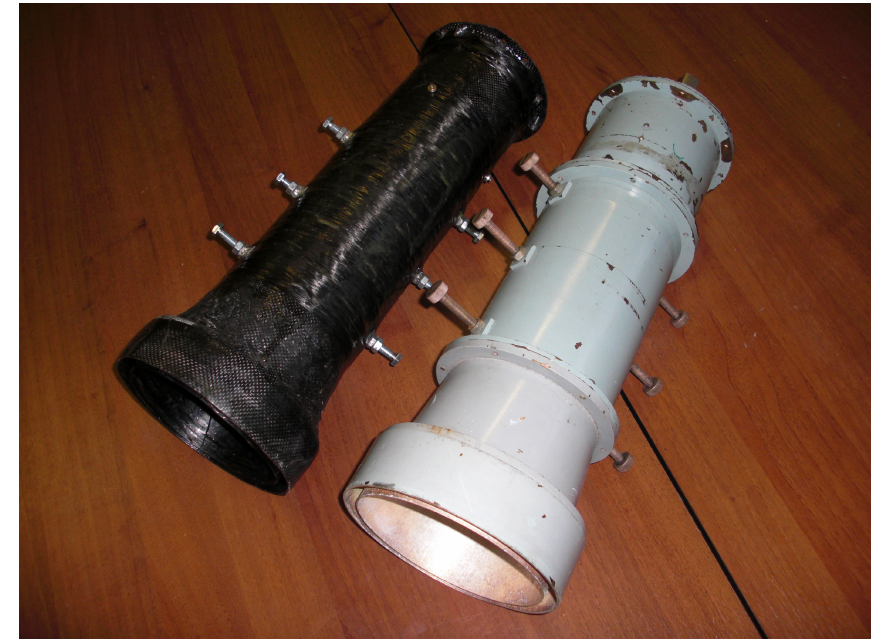
Figure 8. View of L -range horn antennas with polarization units made from fiber (left) and metal